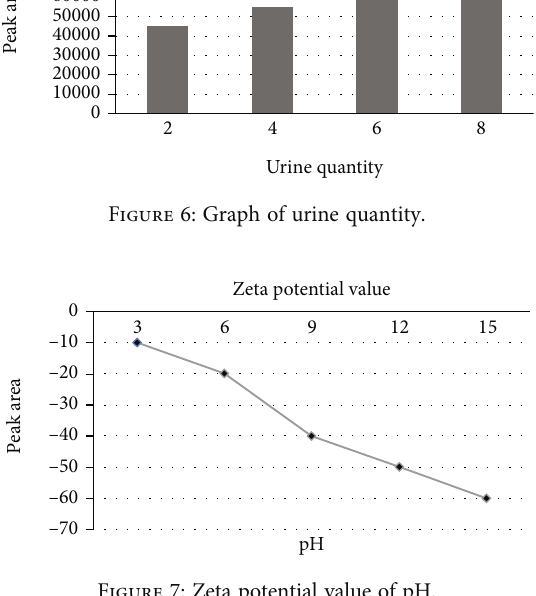
Figure 7: Zeta potential value of